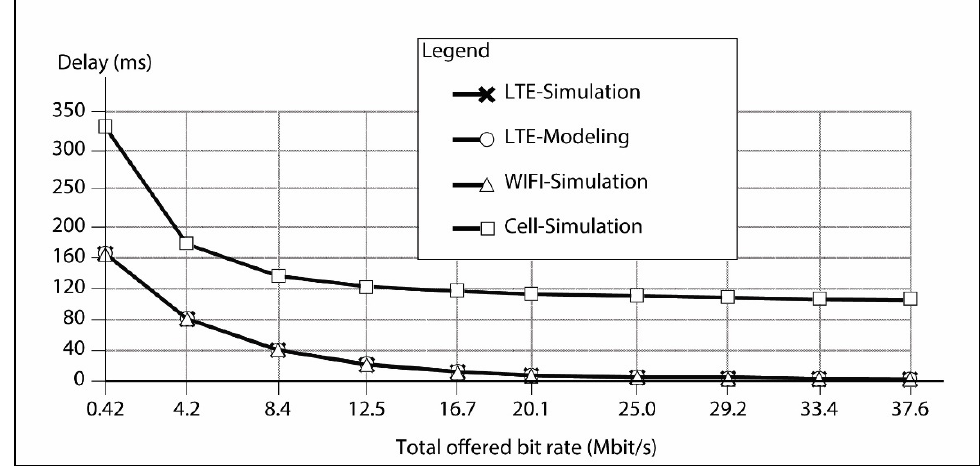
Figure 7. Delay with the coexistence.